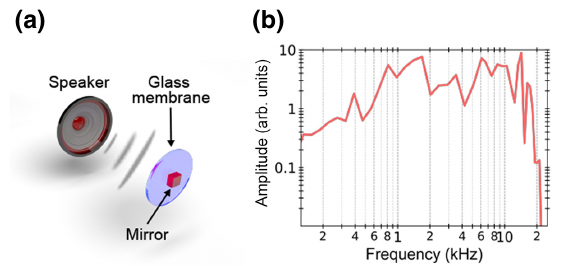
FIG. 3. The acousto-optical transducer. (a) A glass membrane with a diameter of 12.7 mm and a thickness of 70 μ m translates acoustic pressure waves into a physical displacement. Photons are reflected by a small dielectric mirror that is glued on the mem- brane (mirror size 2 × 2 × 0.5 mm 3 ). (b) The frequency response of the transducer under single-tone excitation.